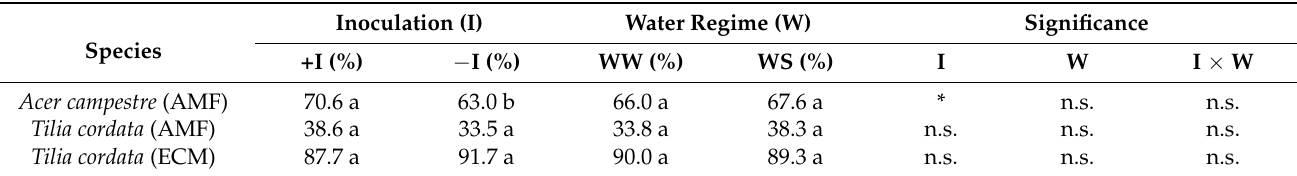
Table 1. Effect of nursery preconditioning techniques, i.e., mycorrhizal inoculation (with arbuscular mycorrhizae fungi (AMF) and/or ectomycorrhizae (ECM)) and water regime, and their interaction on mycorrhizal colonization of Acer campestre L. and Tilia cordata Mill. measured 34 months after transplanting (i.e., 54 months after inoculation).